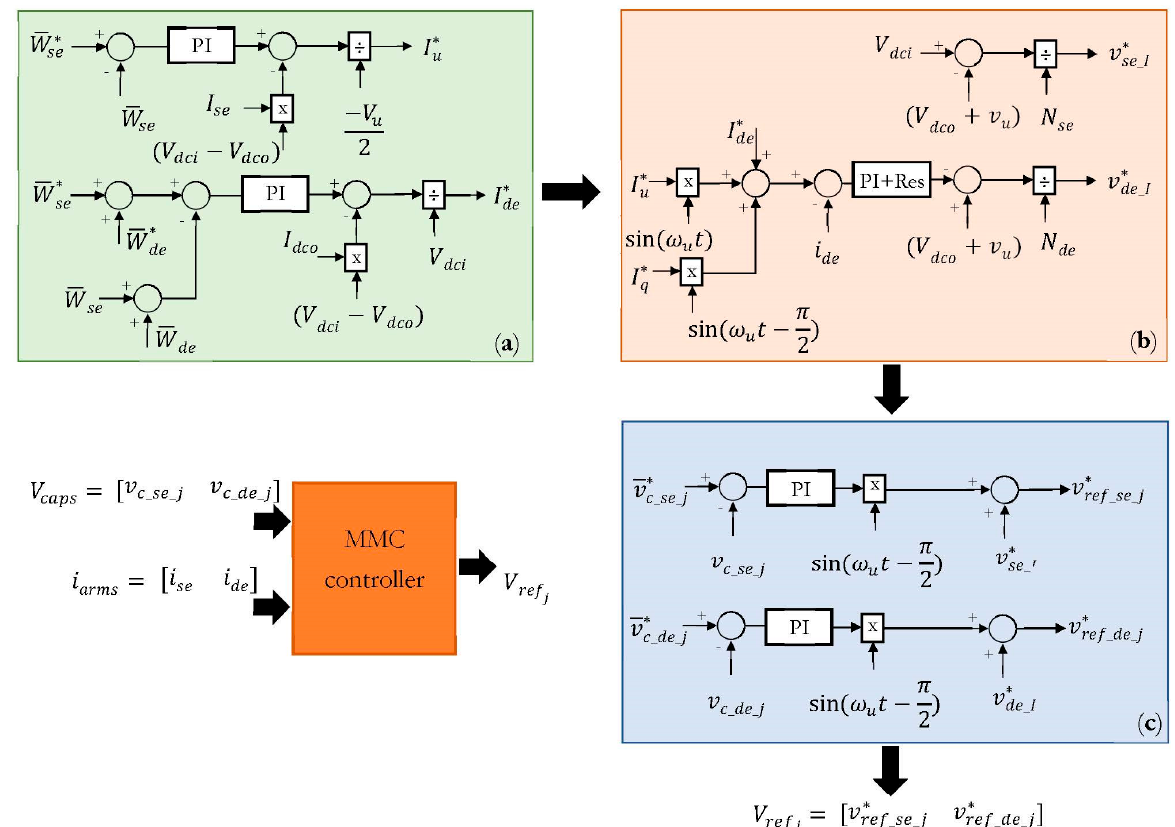
Figure 3. Overview of the developed double- Π MMC controller.